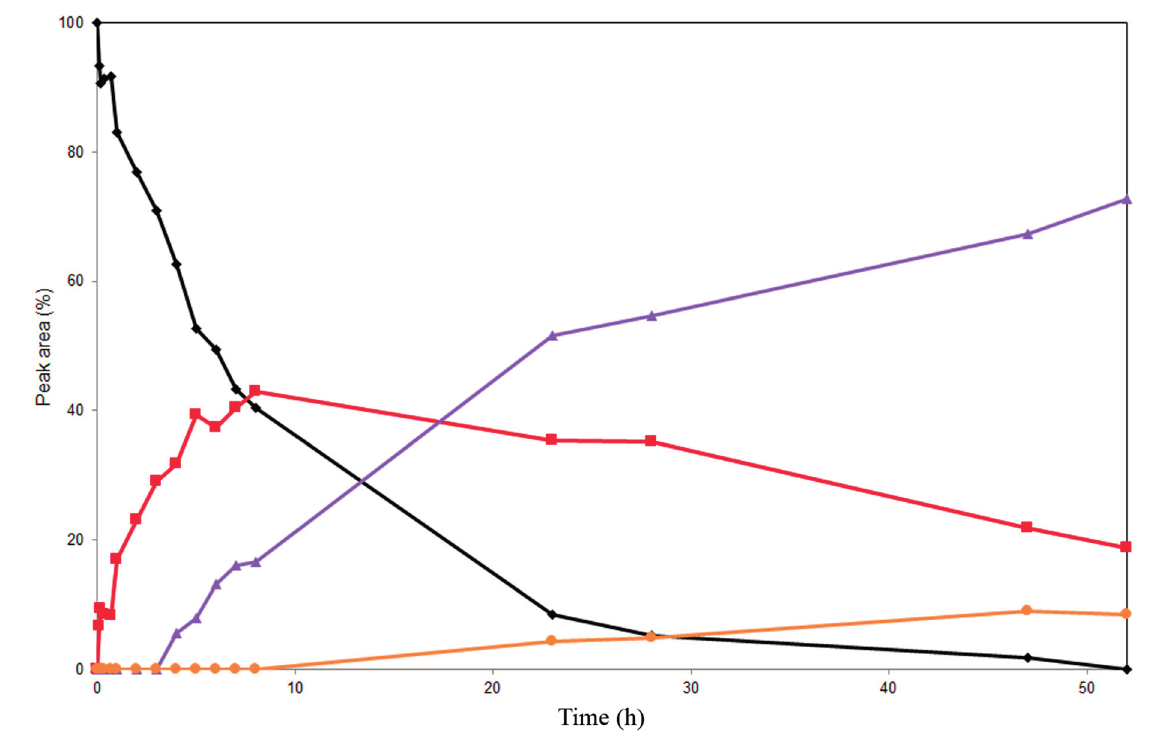
Figure 5. Time course study of the alcoholysis of silychristin peracetate ( 3 ,  ) at 45 °C in MTBE/ n -butanol catalyzed by Novozym 435. Products (3,5,7,15,22-penta- O -acetyl silychristin, 7 ,  ), (3,5,15,22-tetra- O -acetyl silychristin, 8 , ▲ ) and ( 6 , 